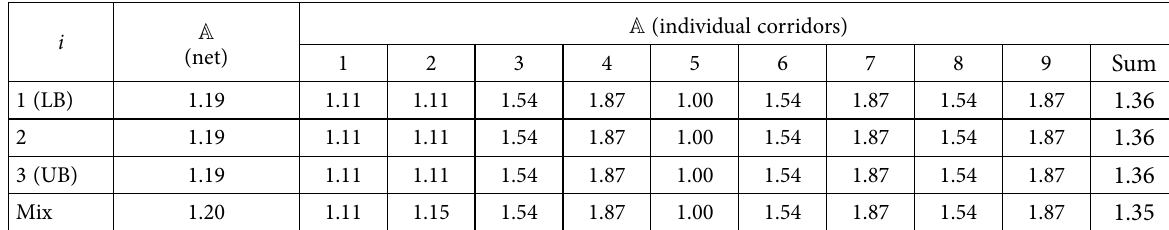
Table 8. Ratio of Table 7 to Table